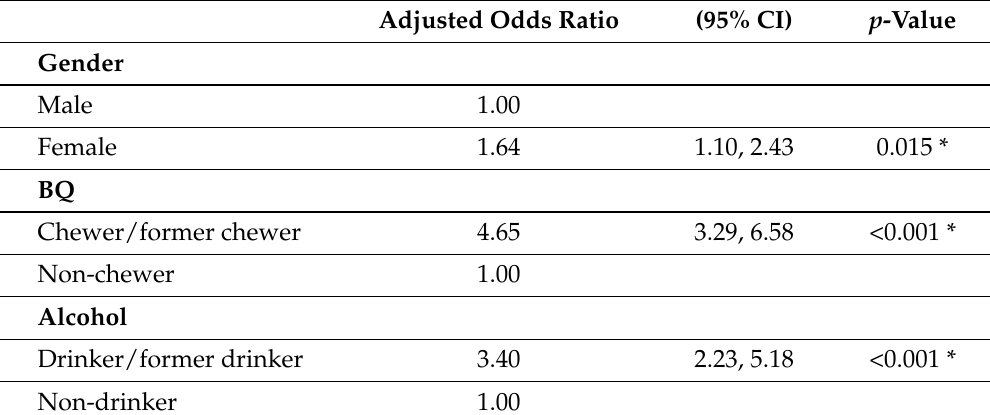
Table 4. Adjusted odds ratios of personal data, and risk factors with OPMD